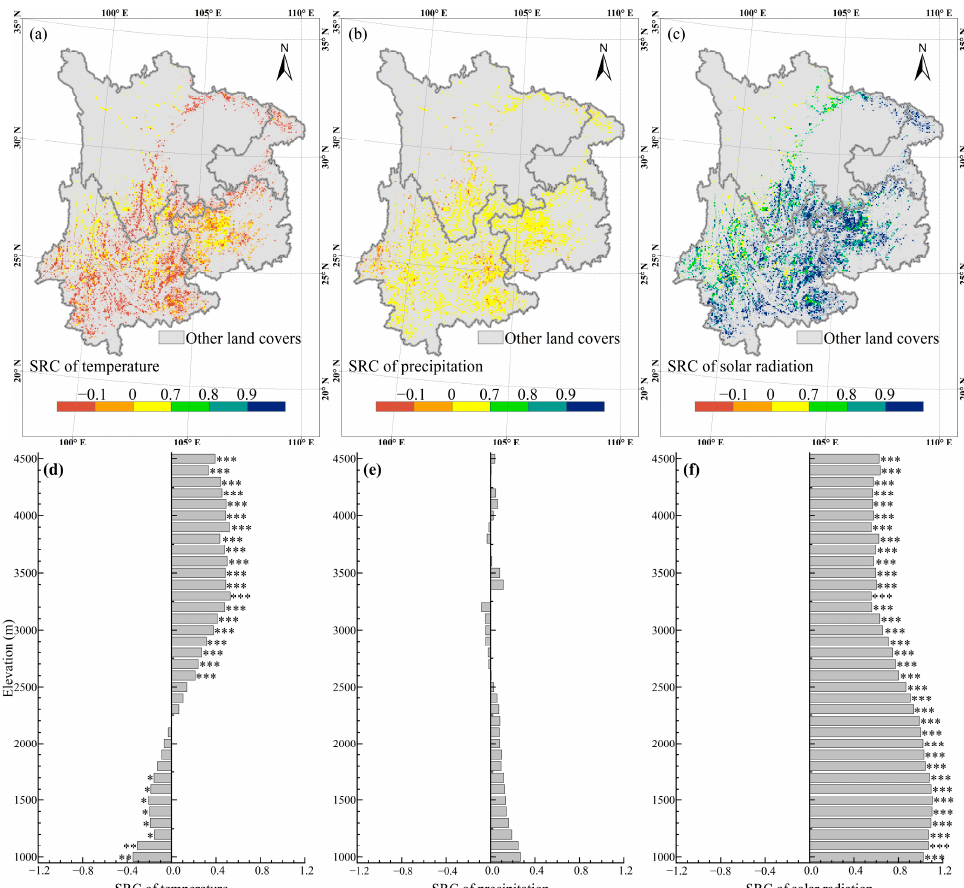
Figure 6. Spatial patterns and elevational gradients of standardized regression coefficient between cropland ecosystem NPP and climate factors, respectively. Subfigure ( a – c ) show spatial patterns of SRCs of temperature, precipitation, and solar radiation respectively, while subfigure ( d – f ) show elevational gradients of SRCs of temperature, precipitation, and solar radiation respectively. One asterisk next to column bar means the correlation reached a statistically significant level ( p < 0.05). Two asterisks next to column bar refer to a p ‐ value of the correlation of less than 0.01. Three asterisks next to column bar refer to a p ‐ value of the correlation of less than 0.001. 4. Discussion Cropland ecosystem NPP converted from increasing to decreasing along increasing elevations in the alpine region of the southwest China. The high values above 800 gC m − 2 year − 1 were at elevations between 1600–2600 m ASL. Crop photosynthetic capacity has a positive correlation with temperature, but this positive correlation also applies to photorespiration and dark respiration [39]. Thus, the maximum NPP tends to occur under medium temperatures [40]. In the study area, mean annual temperature decreased along increasing elevations [12]. The medium temperatures existed between 1600–2600 m ASL, which was located in the central part of Yunnan Province. Its mean annual temperature was between 10.11–15.35 °C, while its annual total precipitation was between 983–1098 mm. Below 1500 m ASL, croplands were located in east and northeast parts of the study area, the river valley in the southern part of the Yunnan ‐ Guizhou Plateau. These regions were situated in the humid subtropical climate zone with air temperature being between 15.64–15.91 °C and precipitation being between 1103–1150 mm. In the humid subtropical climate zone, sufficient hydrothermal conditions were conducive to photosynthesis, but the higher temperature caused autotrophic respiration to consume more photosynthetic products [41]. Moreover, the east part of the study area is the main karst area in China, with poor soil and hydrothermal conditions. In this region, soil erosion is easily triggered